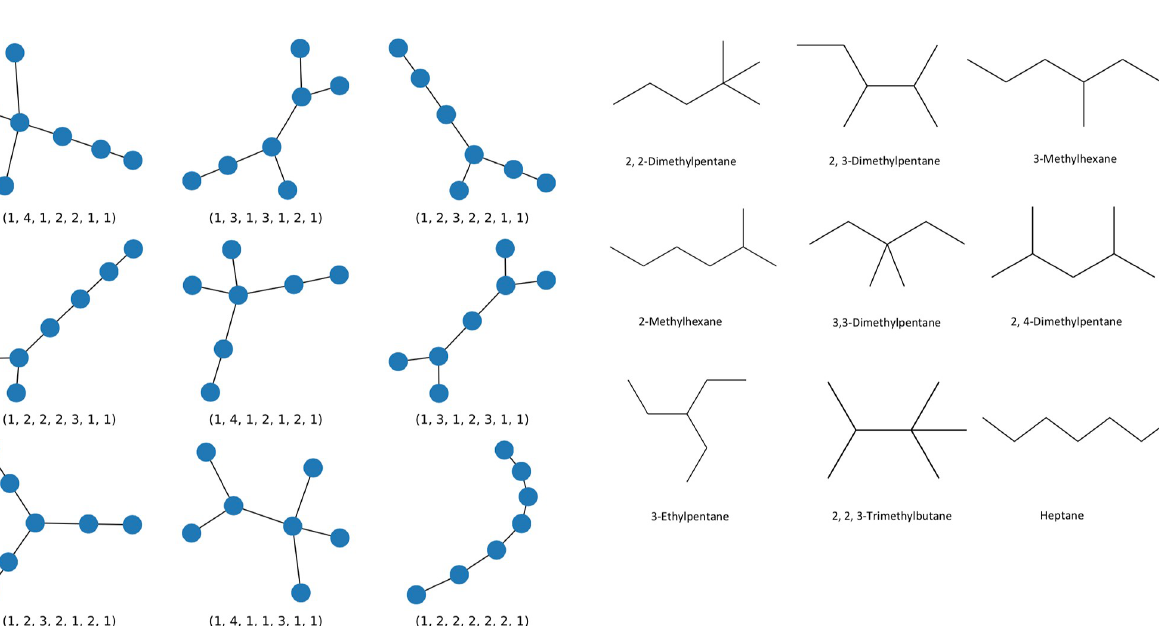
PLOS ONE | https://doi.org/10.1371/journal.pone.0226787 January 15,